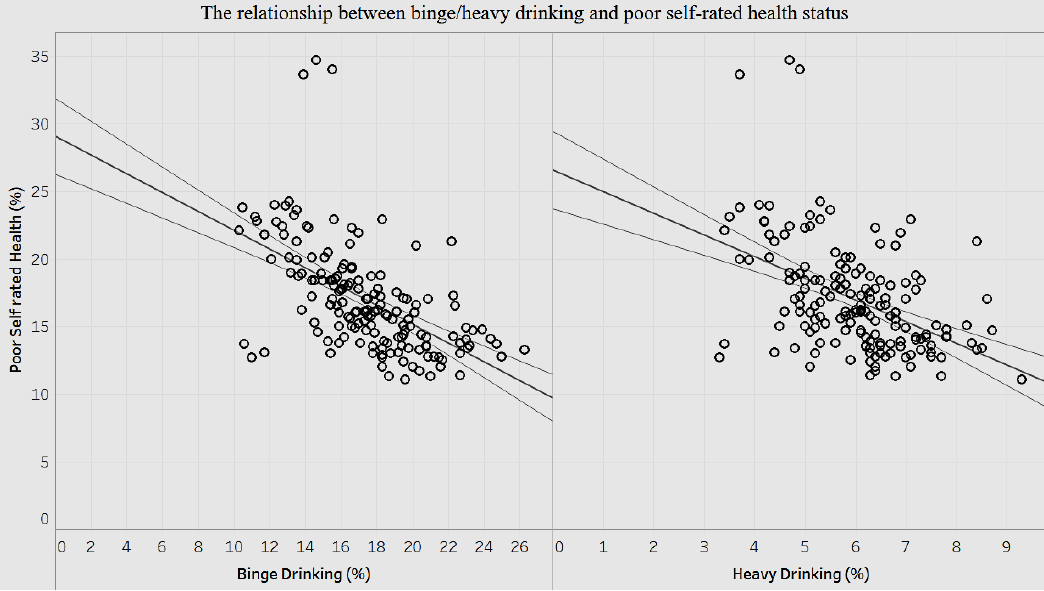
Figure 16. Binge/heavy drink and poor self-rated health status.